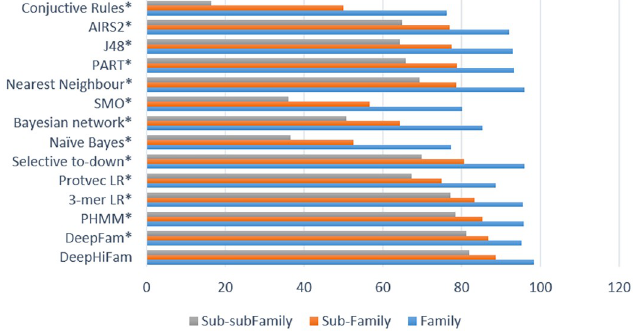
Fig 6. Prediction accuracy (%) comparisons of GPCR dataset. Results are extended from DeepFam [18]. This chart shows that our model has the power of hierarchical classification simultaneously using